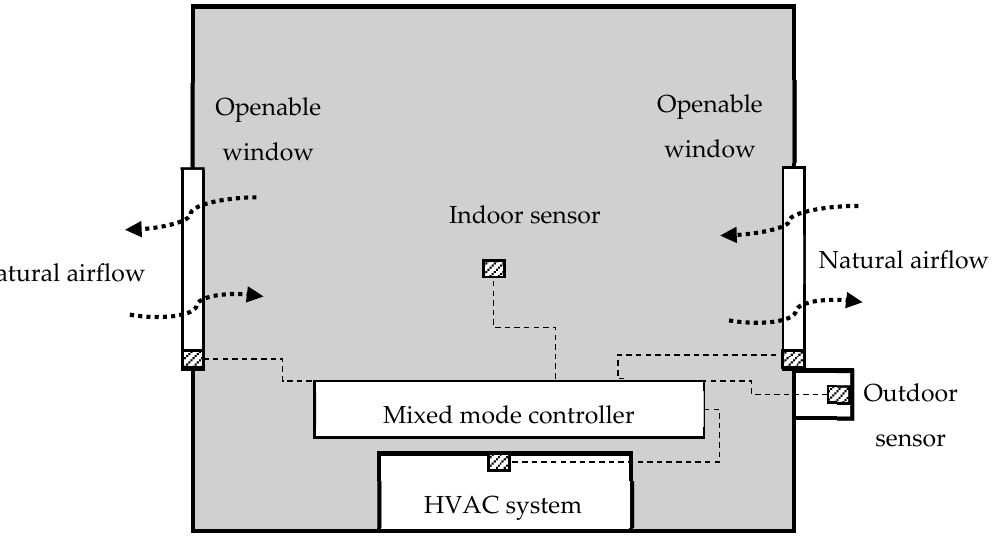
Figure 2. The schematic mixed-mode HVAC system [12,29].